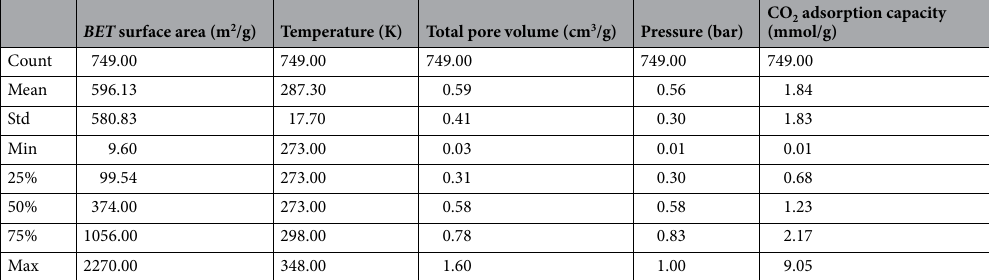
Table 1. Detailed information of data acquired after outlier detection.